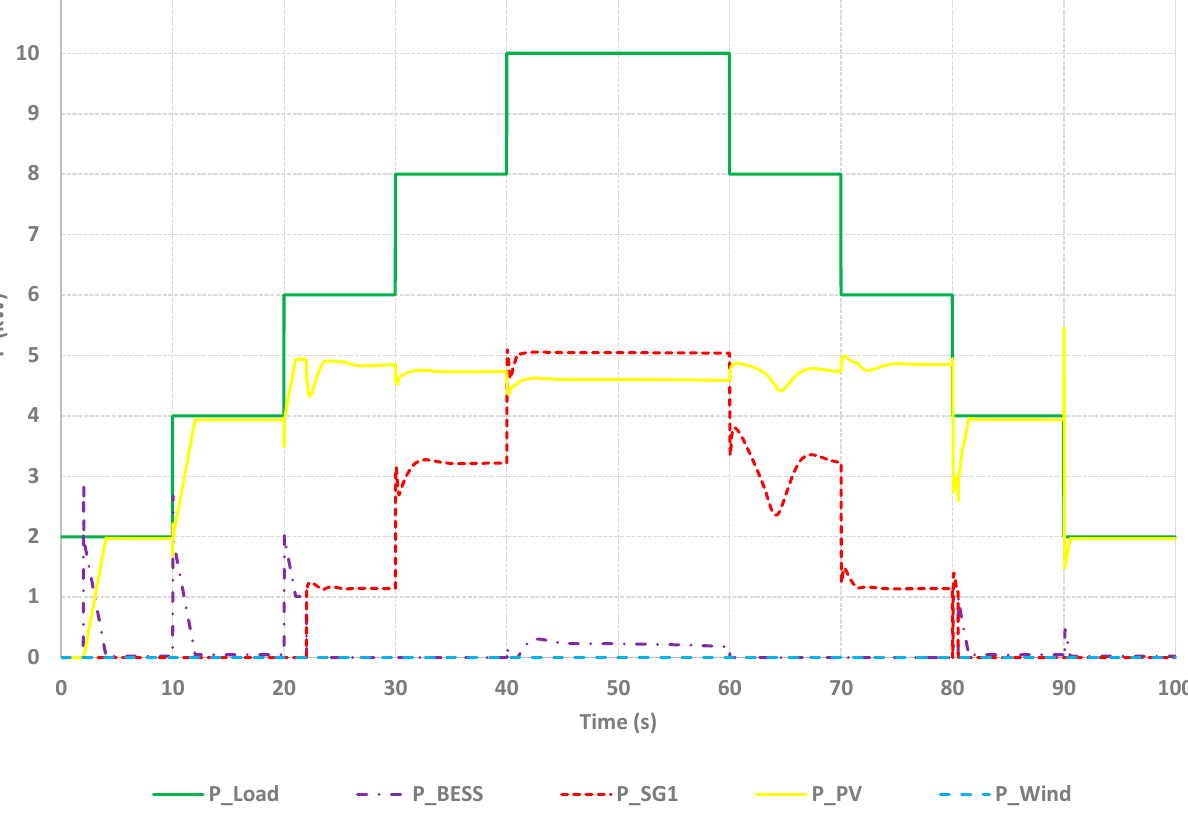
Figure 12. Scenario 2: Variable demand curve, maximum solar PV generation and zero wind generation with BESS.